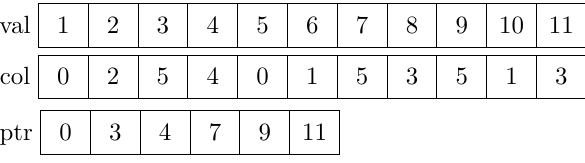
Figure 3. The compressed sparse row (CSR) representation of matrix A